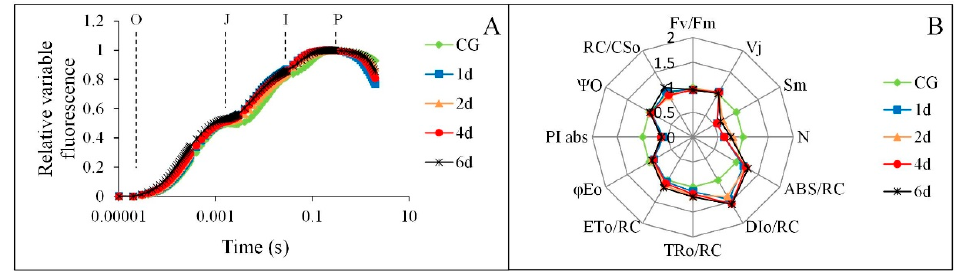
Figure 2. Effects of 38 °C heat stress on chlorophyll a fluorescence transient ( A ) and chlorophyll a fluorescence parameters ( B ) in M. ‘Prairifire’ leaves. Data are each the mean of 6 independent measurements. CG: Plants were treated with CG conditions; 1d: Plants were treated with 38 °C heat shock for 1 day; 2d: Plants were treated with 38 °C heat shock for 2 days; 4d: Plants were treated with 38 °C heat shock for 4 days; 6d: Plants were treated with 38 °C heat shock for 6 days.